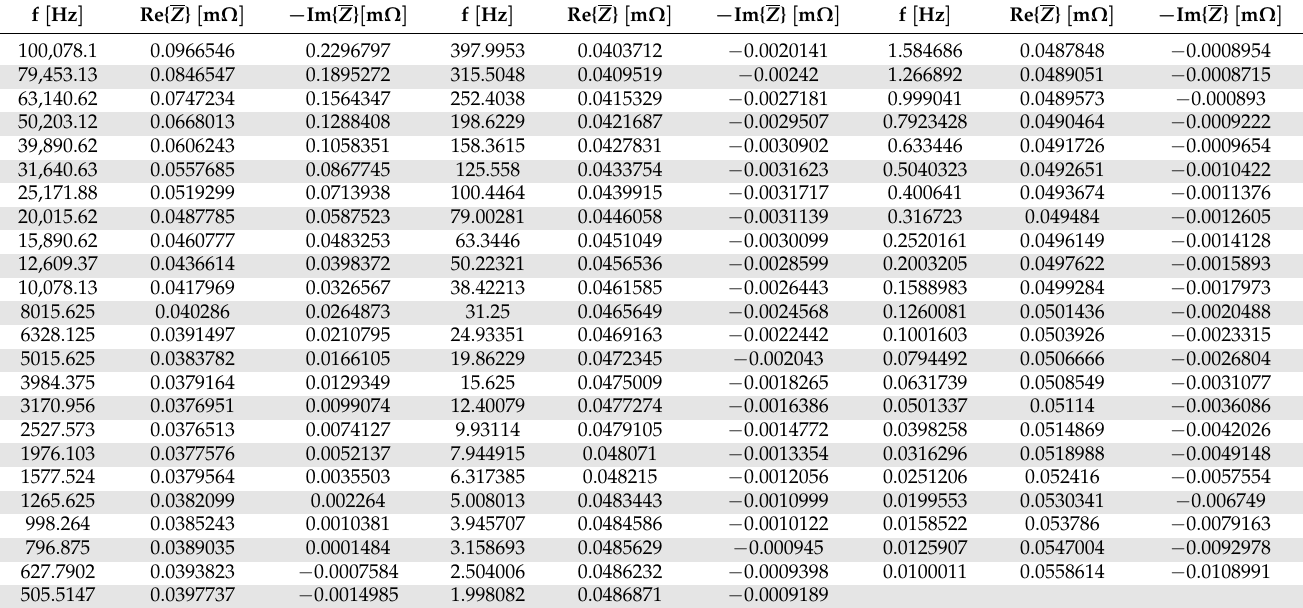
Table A4. EIS data for LG Chem M26 at an SOC of 50%.